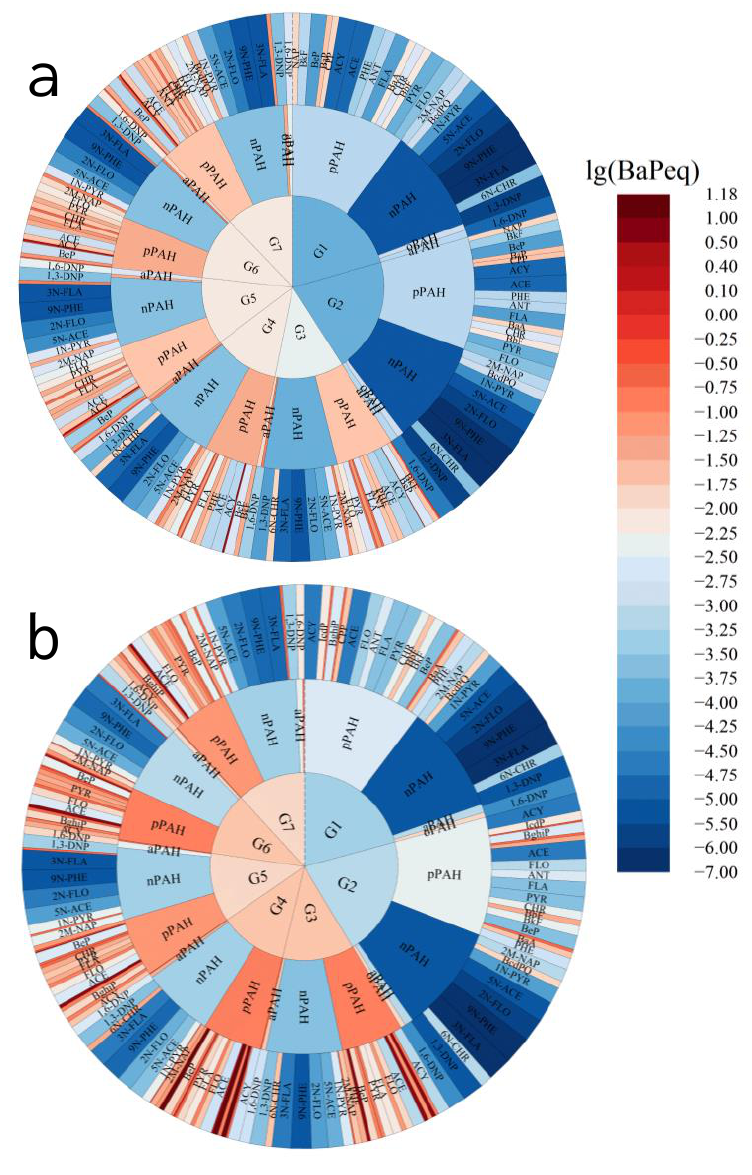
Figure 2. The contribution of four subgroups and individual species PAHs obtained from seven fuel– stove combinations combustion to total BaPeq (( a ) refers to gas phase BaPeq, ( b ) refers to particulate phase